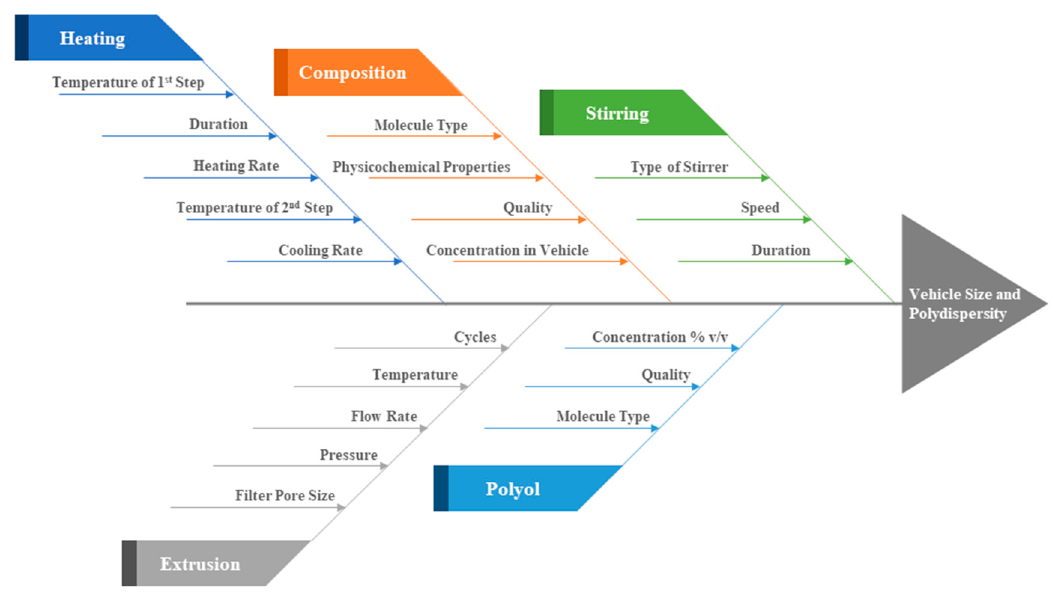
Figure 4. Ishikawa diagram illustrating the main parameters that affect the MHM in terms of lipidic vehicle size and polydispersity.